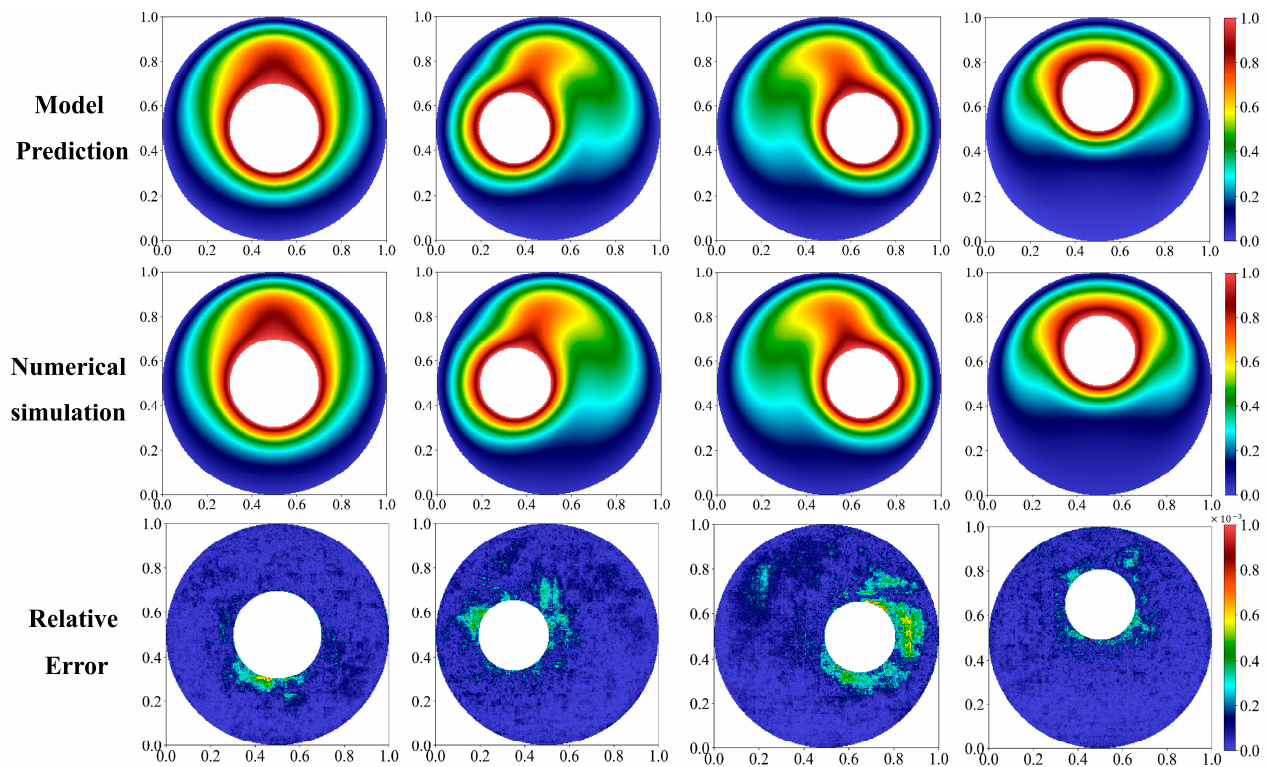
Figure 3. Temperature field predictions of four representative single inner-cylinder annulus with various inner cylinder diameters and positions.